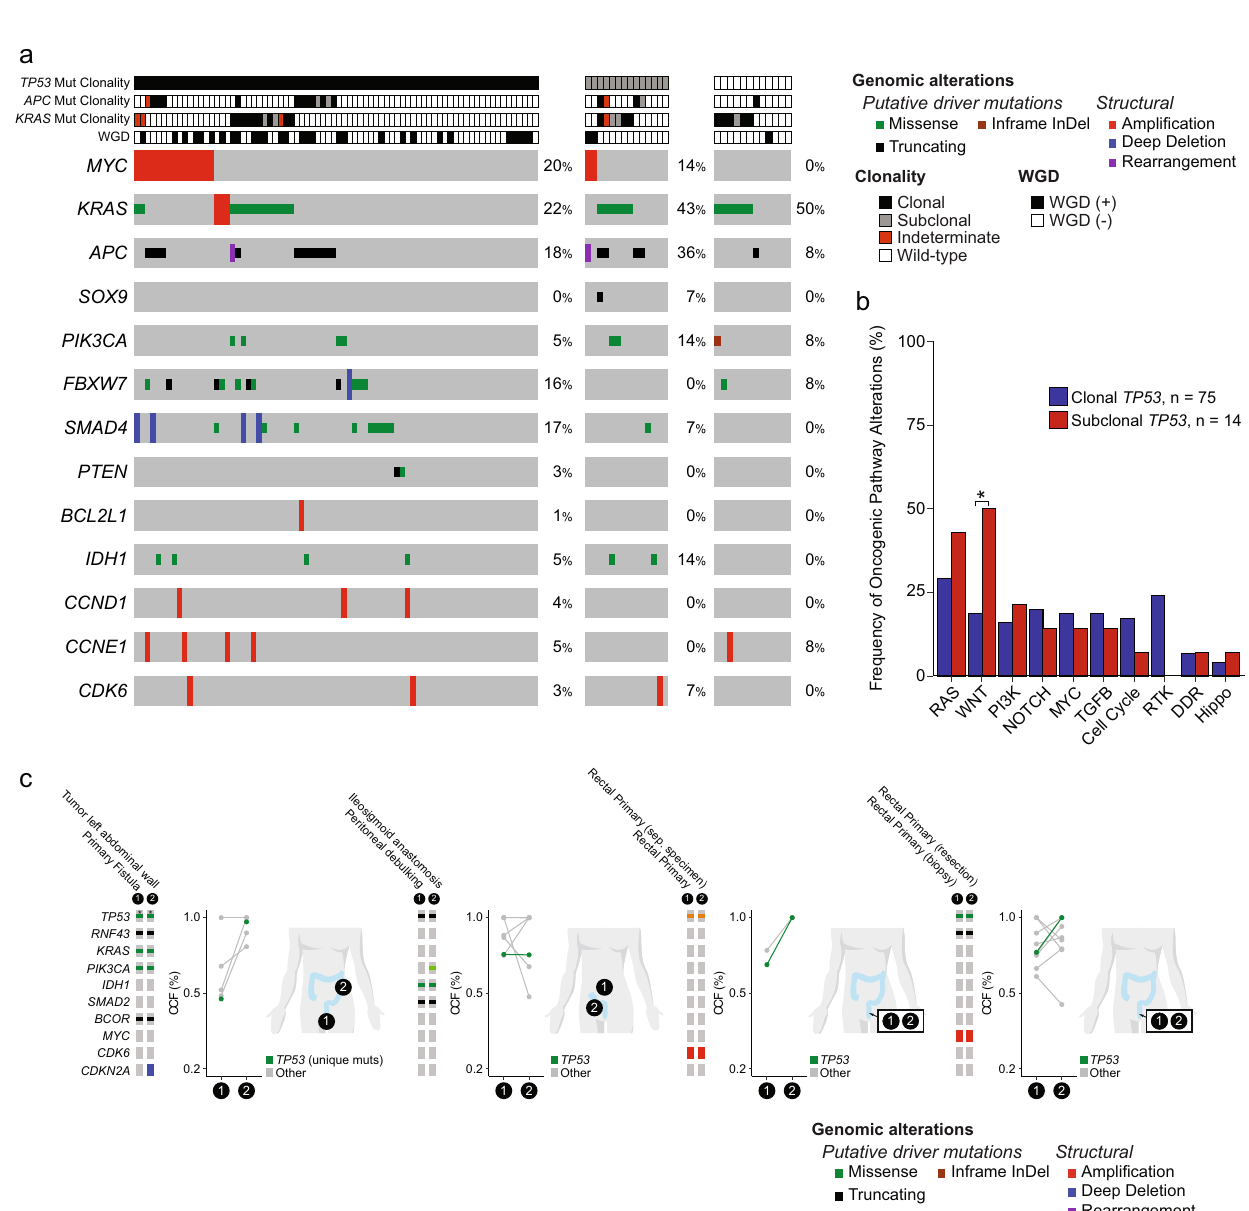
Fig. 3 | TP53 clonality and concurrent alterations. a Oncoprint of recurrent genomic changes by TP53 status (clonal, subclonal, or wild-type). b Frequency of pathway alterations by TP53 clonality. Asterisk indicates signi fi cant difference in comparisons performed with two-sided Fisher ’ s exact test. The Wnt pathway was signi fi cantly enriched in the subclonal TP53 group versus the clonal TP53 group